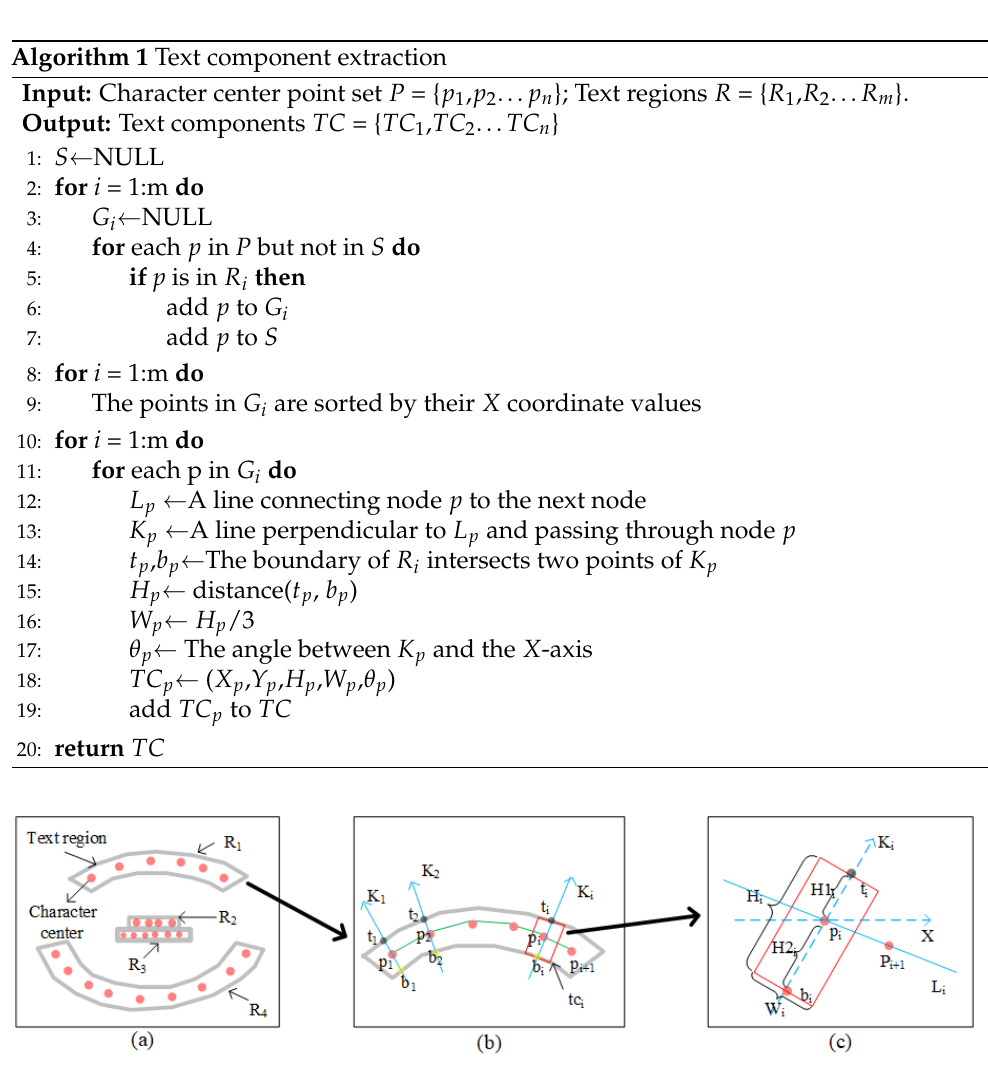
Figure 4. The processing flow of text component generation. ( a ) The result of character center point grouping. ( b ) Text region R 1 and its character center points. ( c ) One of the text